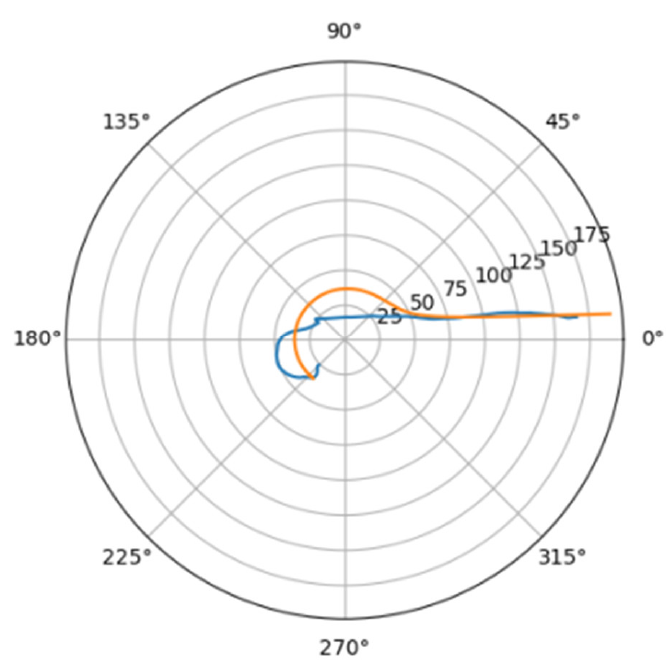
Figure 10. Approximations for she_a.